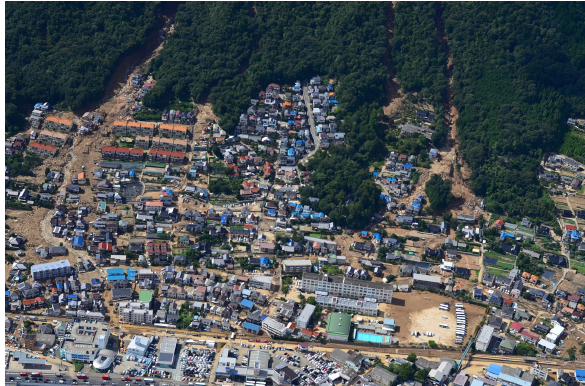
Figure 1. Sediment disaster (Hiroshima City Asaminami Ward Yagi